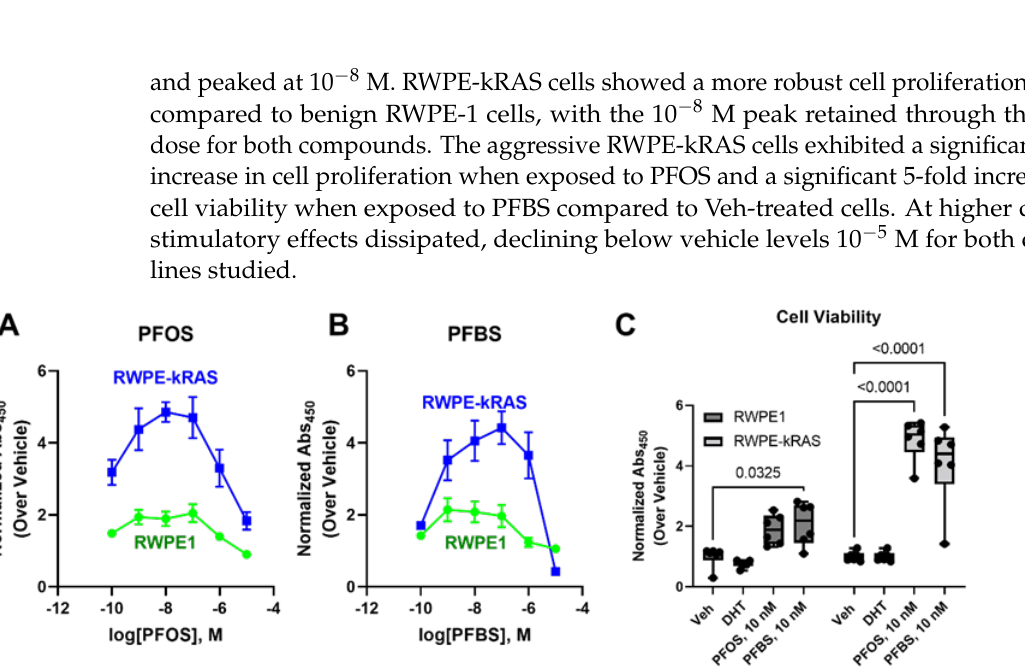
Figure 1. WST-1 assay shows that PFOS ( A ) or PFBS ( B ) exposure for 1 week increases cell viability of prostate benign (RWPE-1) and cancerous (RWPE-kRAS) cells ( C ). Comparison of cell viability of RWPE1 and RWPE-kRAS cells, when they are treated with Veh, 1 nM DHT, or 10 nM of PFAS.